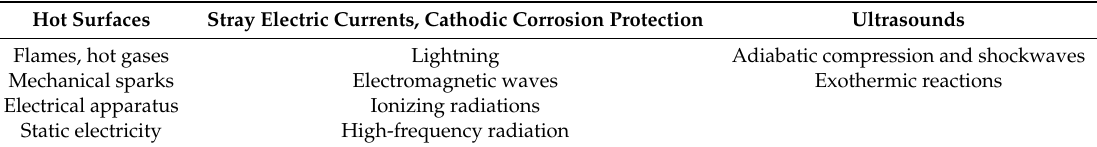
Table 6. Possible ignition sources according to EN 1127-1.